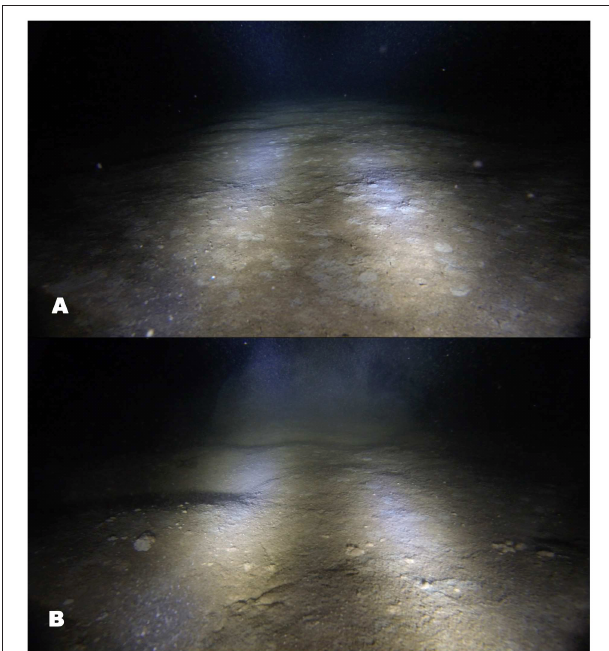
FIGURE 8 | Images from videos taken in 2013 during jump dives to 262m at the Amazon Caves sites. (A) Amazon Caves Jump dive site 1 (23:24): brownish gray sediment with a layer of deposited particles with numerous (40–50% of area) white circular marks and traces of bioturbation including many small faunal features possibly produced by burrowing bivalves, crustaceans, worms etc. The large white circular marks could also be fluid seeping features (fsf) considering the thermal activity in the area. (B) Amazon Caves Jump dive site 2 (00:20): slightly hummocky lakebed covered by sediment with flocculate detritus matter conglomerated in whitish masses and traces of bioturbation (5–10%) and small grooves. Above the sediment surface, one can see the flow of particles and plankton.